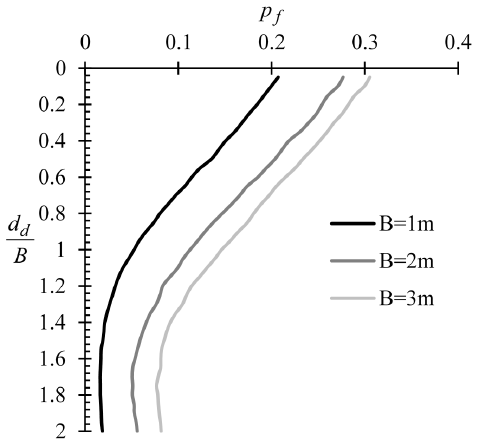
Figure 8. vs. d d / B example curves for θ = 10 m, x / B = 0 and di ff erent footing widths B . Figure 8. versus example curves for θ = 10 m, x/B = 0 and different footing widths B . d d B